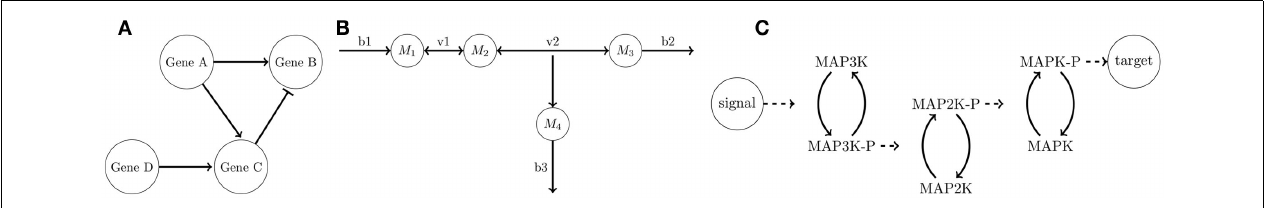
( M i ) are connected with internal ( v i ) or external ( b i ) metabolic fluxes. (C) A signal can lead to a phosphorylation (“-P”) cascade of MAP kinases, and eventually the target is activated or